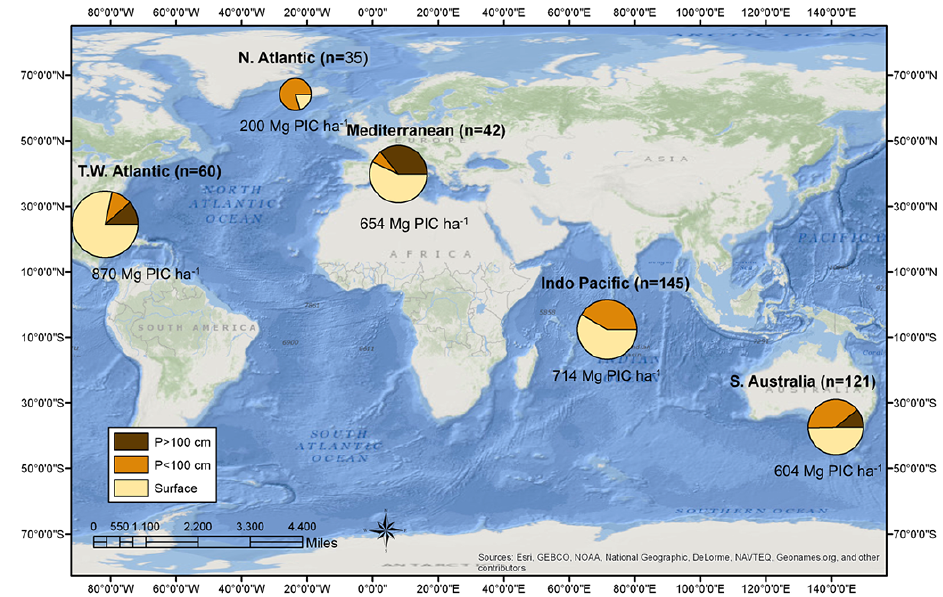
Figure 1. Distribution of the data of PIC stocks in seagrass meadows (average top metre; MgPICha − 1 ) compiled in this study by the biogeographic regions described by Hemminga and Duarte (2000). The size of the pie charts is proportional to the top metre of PIC stocks in each region. The fraction of PIC stocks estimated from surface sediments (yellow) and short sediment cores ( P < 100cm, orange) and longer cores than 100cm ( P > 100cm, brown) is